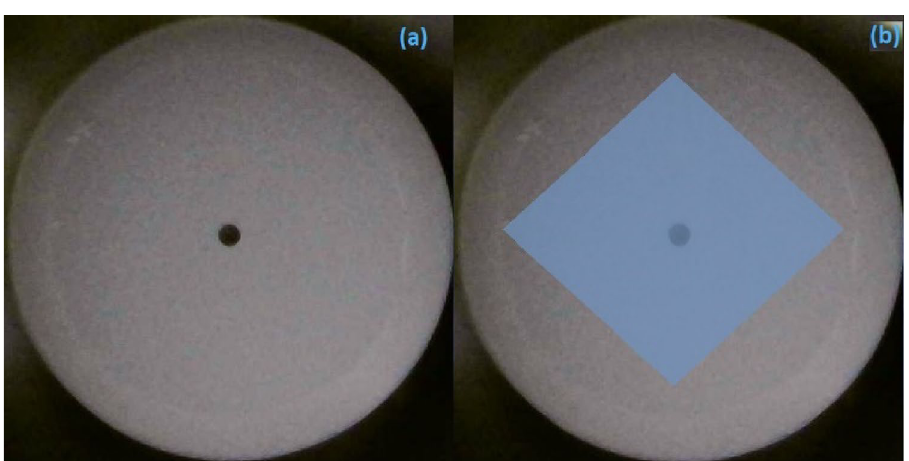
Figure 3. ( a ) Fiber ferrule without thin film deposited and ( b ) with ZnO thin film deposit using SM technique.